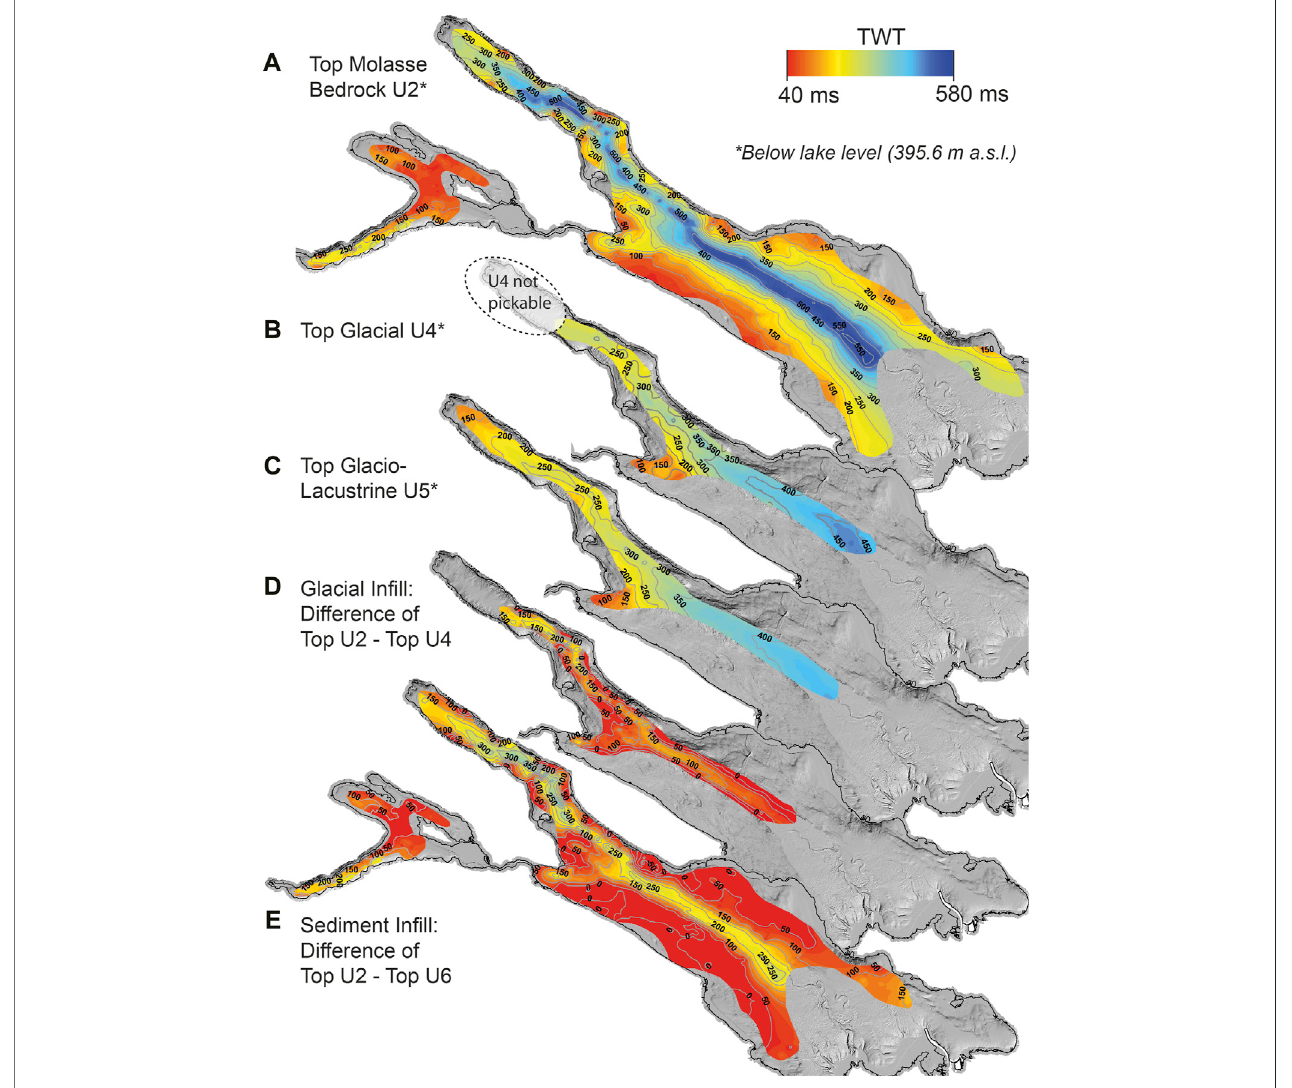
FIGURE 8 | A: Top of Molasse bedrock horizon (in twt) revealing pronounced overdeepening in the center of the OB and UEB with contour lines of bedrock (isochroneintervalof50 ms).B,C:Extentofglacialandglacio-lacustrinedepositscorrespondingtoseismicfaciesunitU4andU5.D,E:Thicknessmaps(50 msintervals) showing the difference of top U2 minus top U4 and top U6, respectively. All data is shown in two-way travel time.